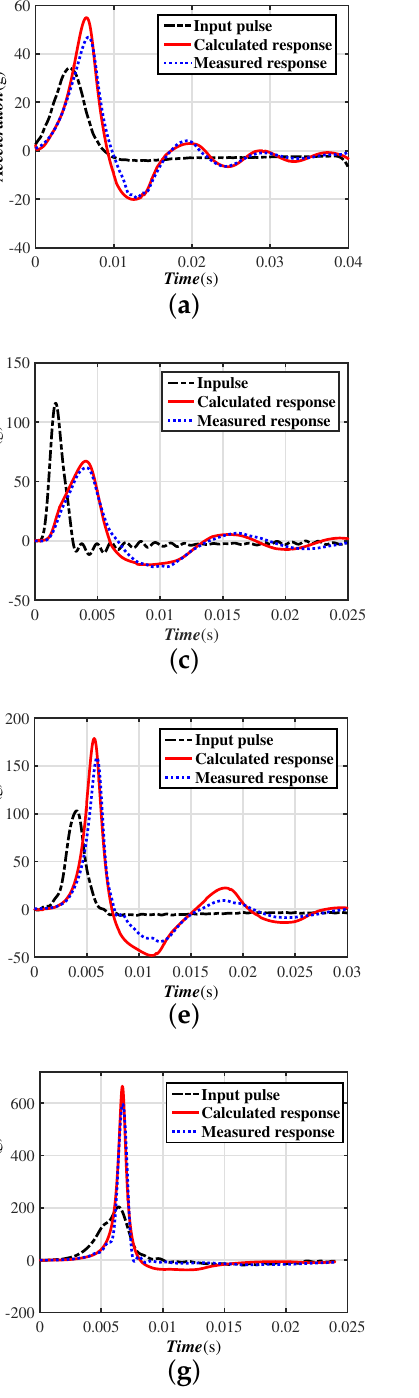
Figure 10. Reconstructed and measured responses of the rubber isolator in the first eight cases.